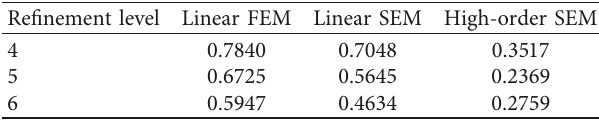
Table 6: L 2 norm of the dynamic condensation distribution at 10ms.